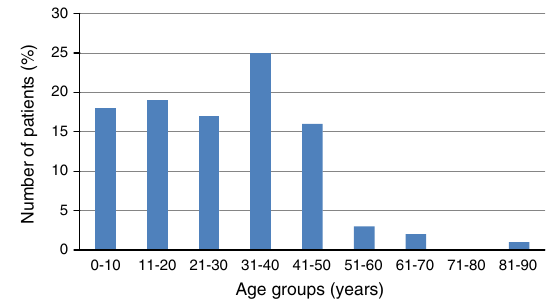
Figure 1 Subjects distribution according to